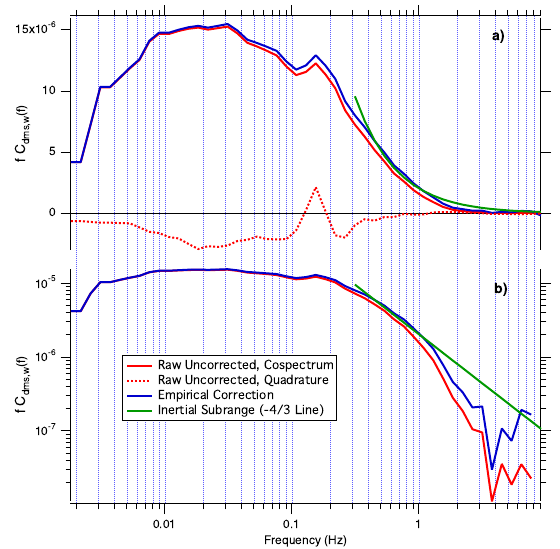
Fig. 10. Mean hourly ( n =294) cospectrum and quadrature spectrum for DMS concentration and vertical wind velocity from a cruise in the Sargasso Sea: (a) semilog format (area proportional to covari- ance), (b) log-log format (linear − 4/3 fall off in the inertial subrange (Kaimal et al. , 1972)). Red traces are uncorrected data. Blue shows the empirical correction for inlet attenuation losses (see Sects. 4.3 and 6.4). The green trace illustrates a further correction to the ex- pected − 4/3 dependence in the inertial subrange. The small peak at ≈ 0.15Hz is a spectral feature at the frequency of wave motion which may be due to motion-gradient effects (see Sect. 6.3), but in this case is seen to contribute little error to the mean